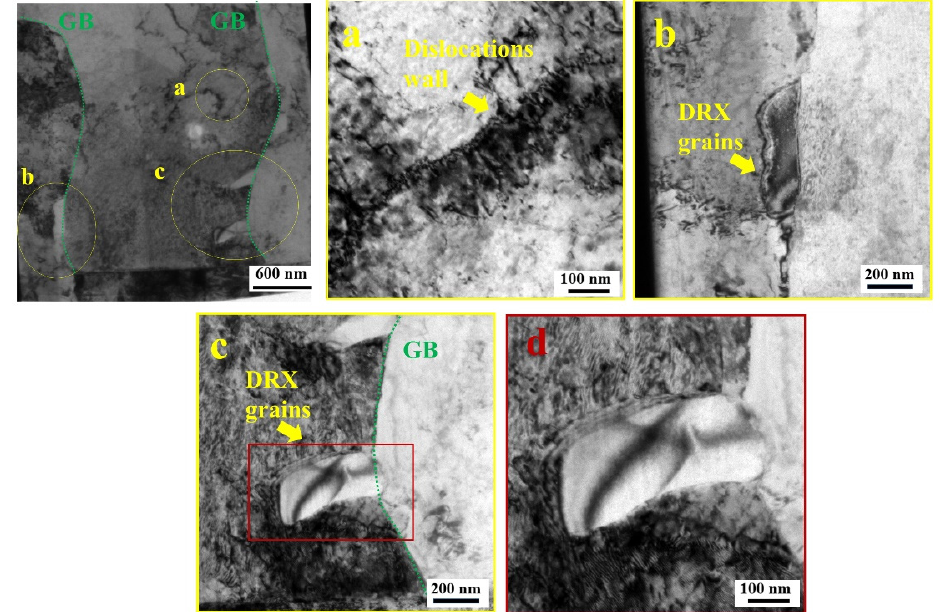
Figure 14. TEM images of the recrystallization mechanism in the deposition sample of 316L. ( a ) Rearrangement of the dislocations during the CDRX; ( b , c ) the formation of DDRX recrystallized grains preferentially found on the GBs (green dotted lines) in sizes ranging from nanometers to micrometers; ( d ) a partial enlargement of ( c ).